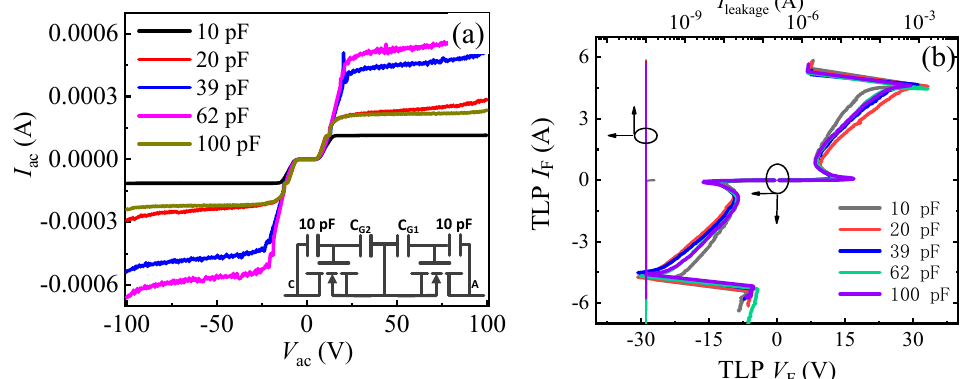
Figure 11. The bidirectional leakage current characteristics ( a ) and TLP I–V characteristics ( b ) of diode 3 with different C G1 ( C G2 ) values. The inset of Figure 11a is the equivalent circuit of diode 3.